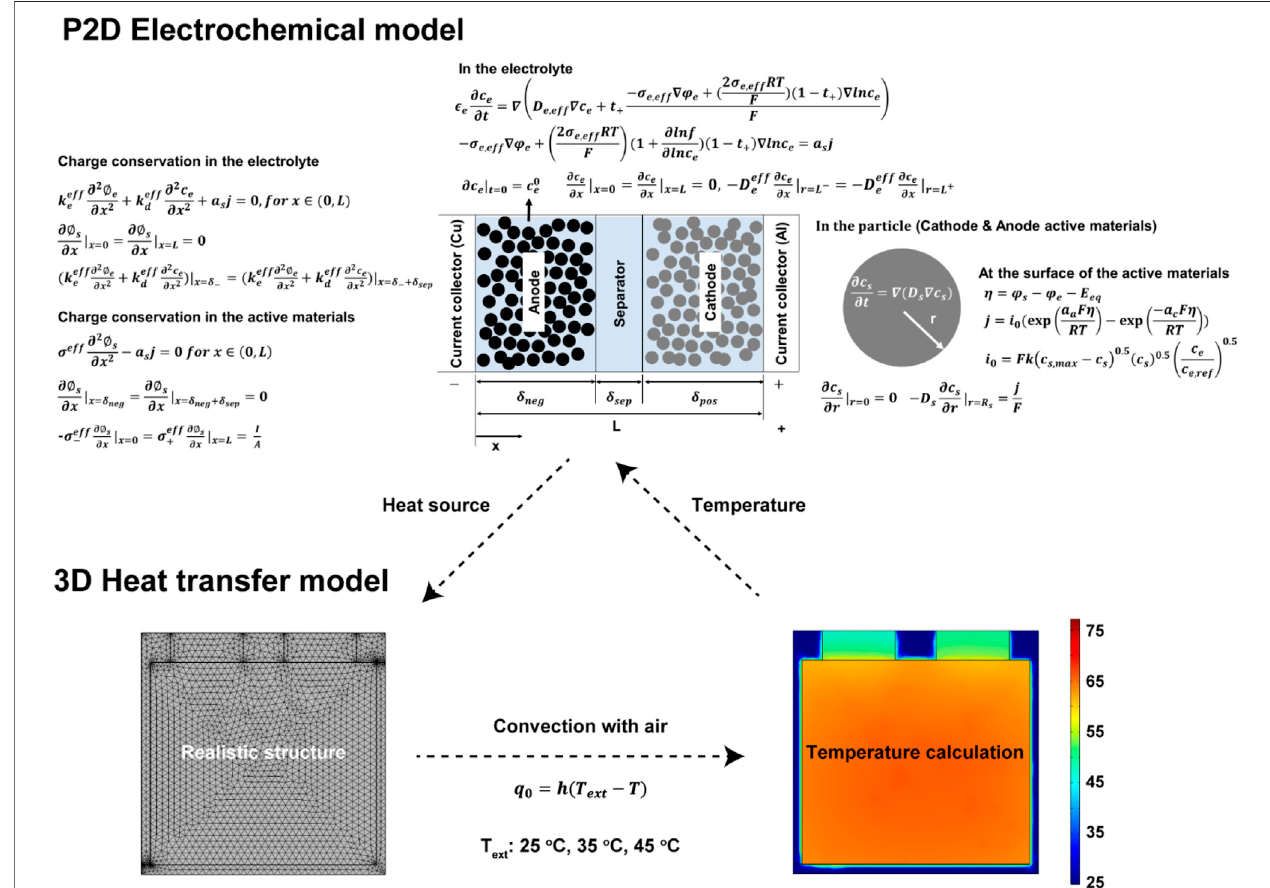
FIGURE 2 | Schematic of the combination of the electrochemical model and heat transfer model, and domains, boundary conditions and equations.